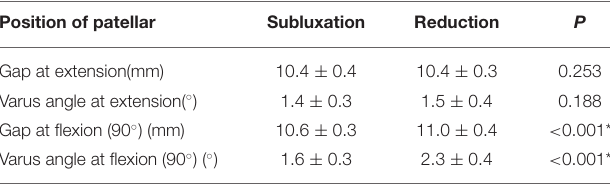
TABLE 3 | Comparison of balance before and after reduction of patella in group B.